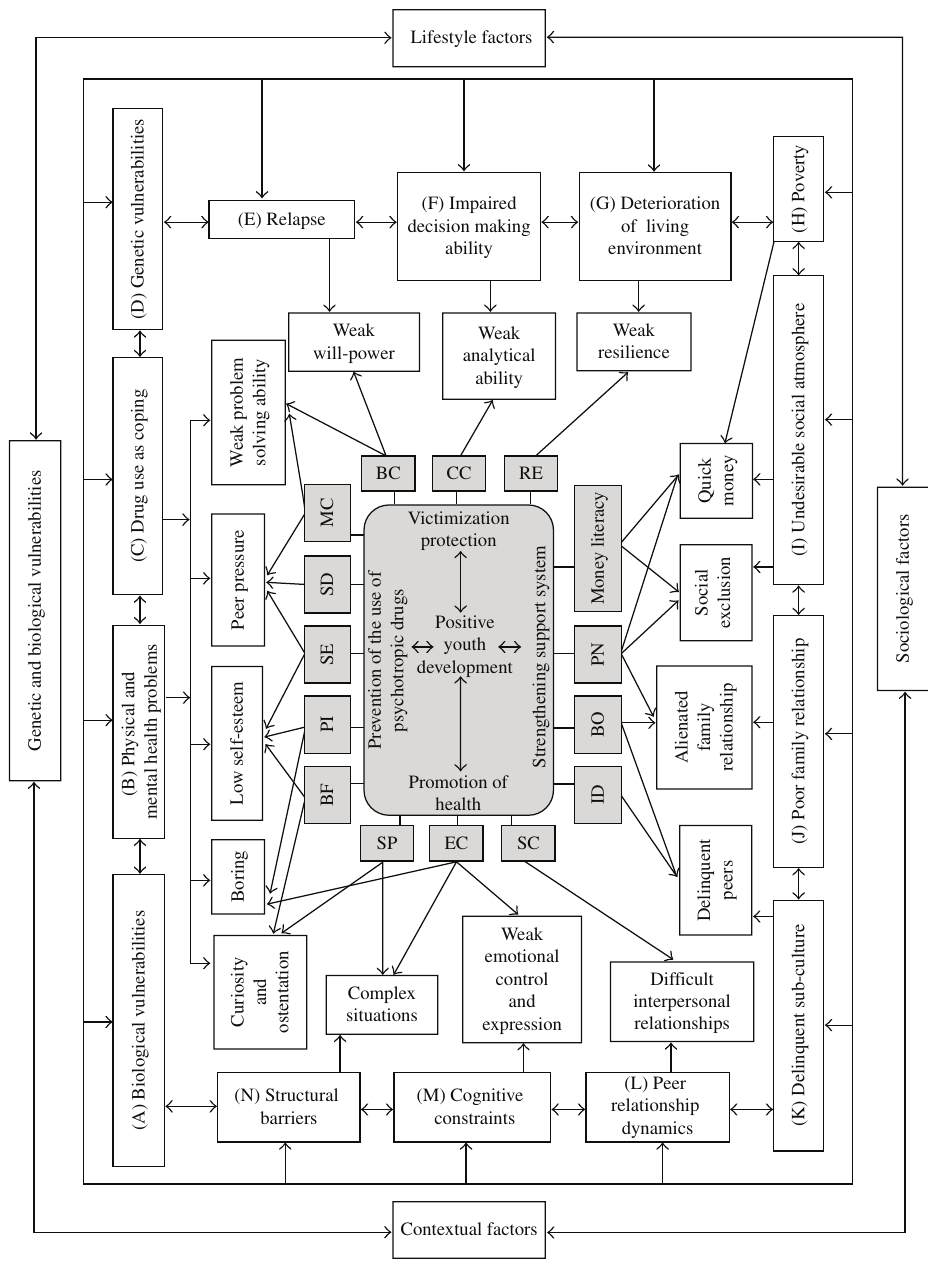
FIGURE 3: An integrated positive youth development conceptual framework for primary prevention of ado- lescent drug